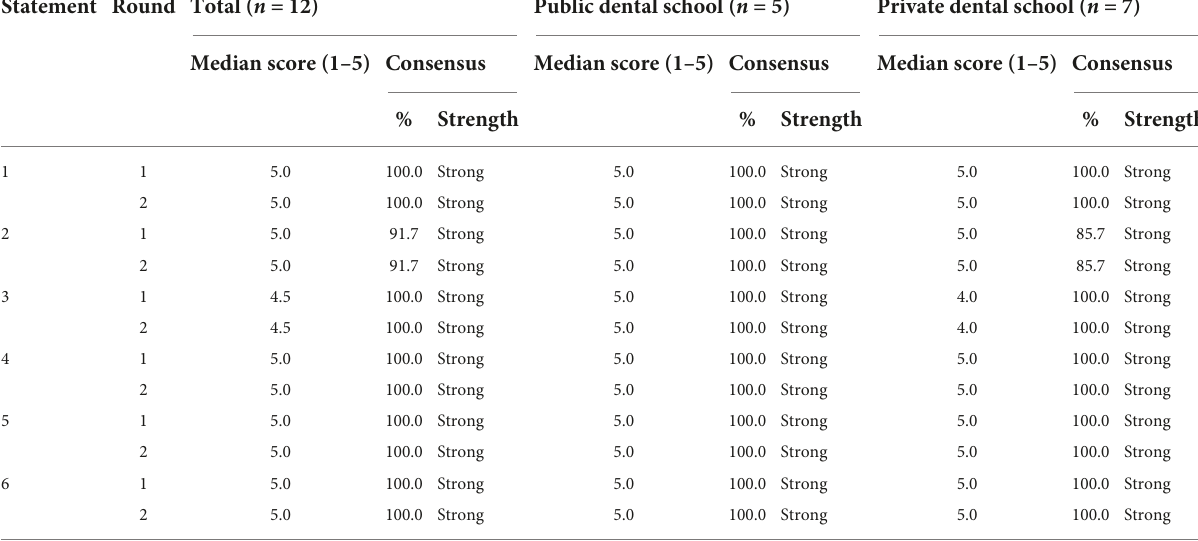
TABLE 4 Consensus on dental education policy statements to sustain safe and effective delivery of the curriculum based on the WHO Six Building Blocks. Statement Round Total ( n =